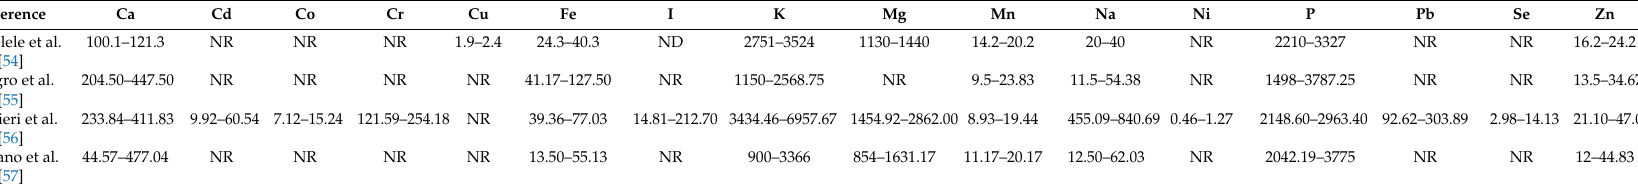
Table 3. Mineral composition (mg / kg, d.b) of